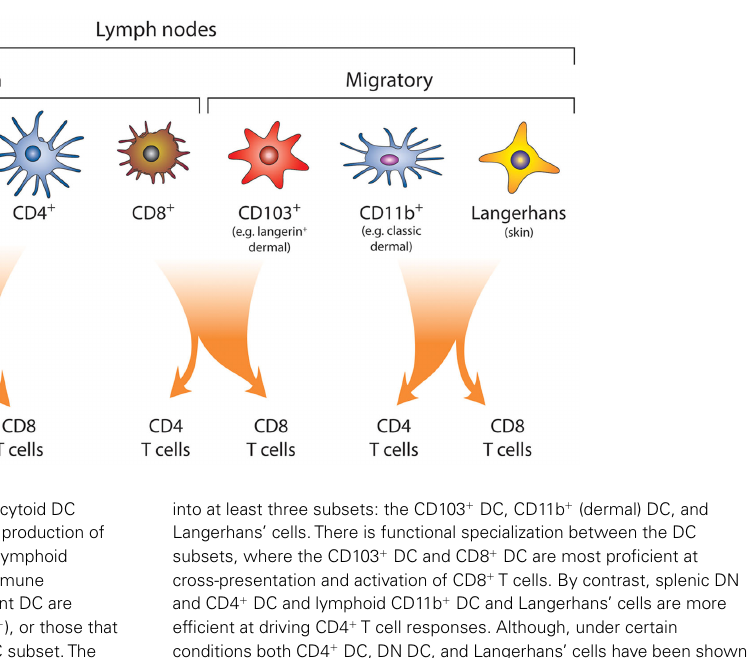
recognizing DC-specific molecules can also be engrafted into stealth liposomes.The liposomes can carry both antigen and cytokines (van Broekhoven et al., 2004). (D) Nanoparticles carrying Ag are modified to permit the attachment of DC-specific mAb and have been used to target Ag (Cruz et al., 2010).